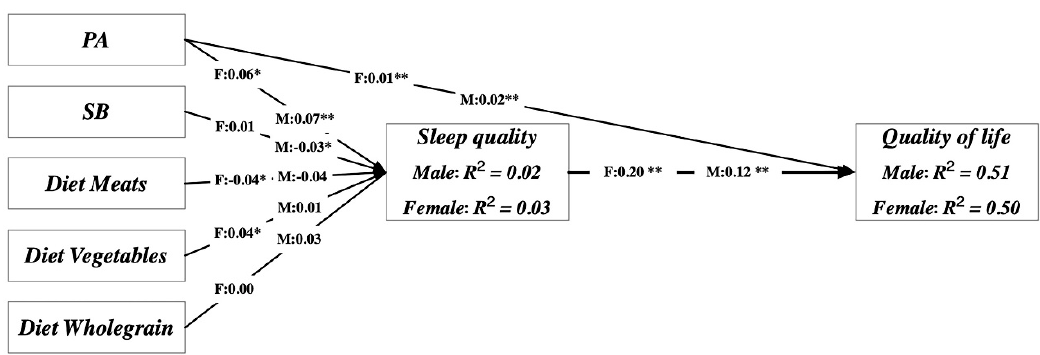
Figure 1. Scheme of path analysis. The model explained 50.9% ( r 2 = 0.509) and 2.4% ( r 2 = 0.024) of the variance in quality of life and sleep quality, respectively, in the male group and 49.6% ( r 2 = 0.496) and 2.8% ( r 2 = 0.028), respectively, in the female group.